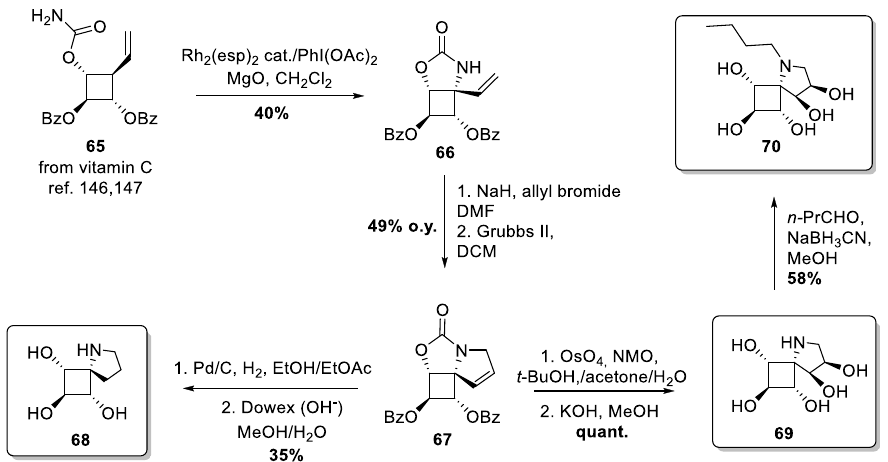
Scheme 9. Synthesis of conformationally constrained iminosugars 68–70 [147,150].